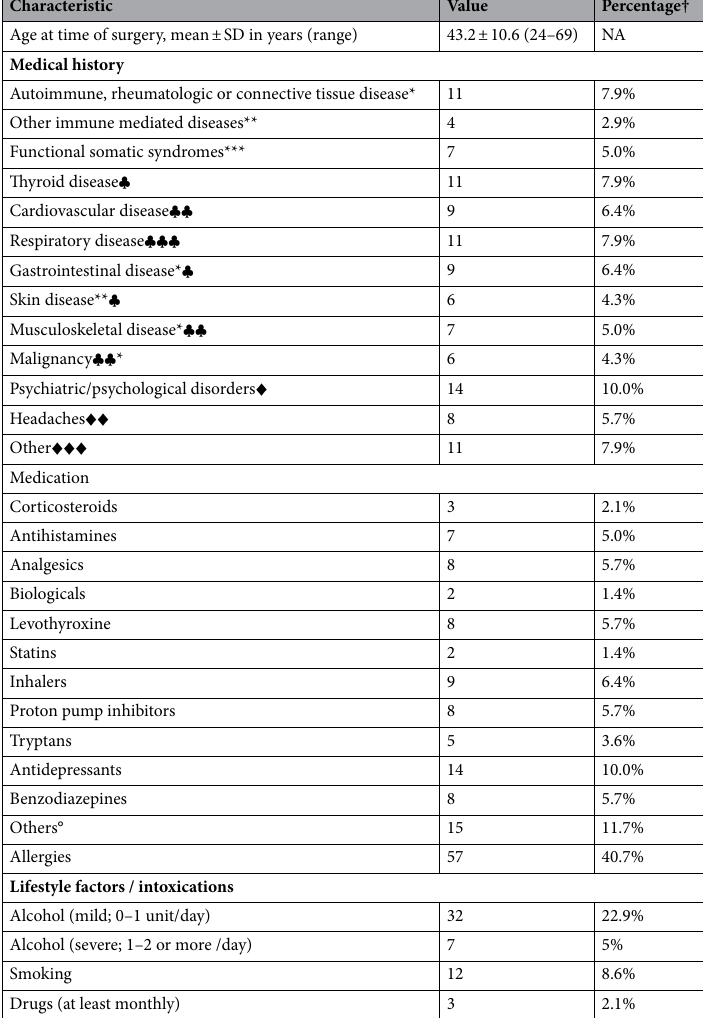
Table 1. Demographic and clinical characteristics of study group (n = 140). *SLE, Sarcoidosis, Rheumatoid arthritis, Raynaud’s phenomenon, Lichen planus, Lichen sclerosus, Ehlers-Danlos, Vitiligo. **IgA deficiency,